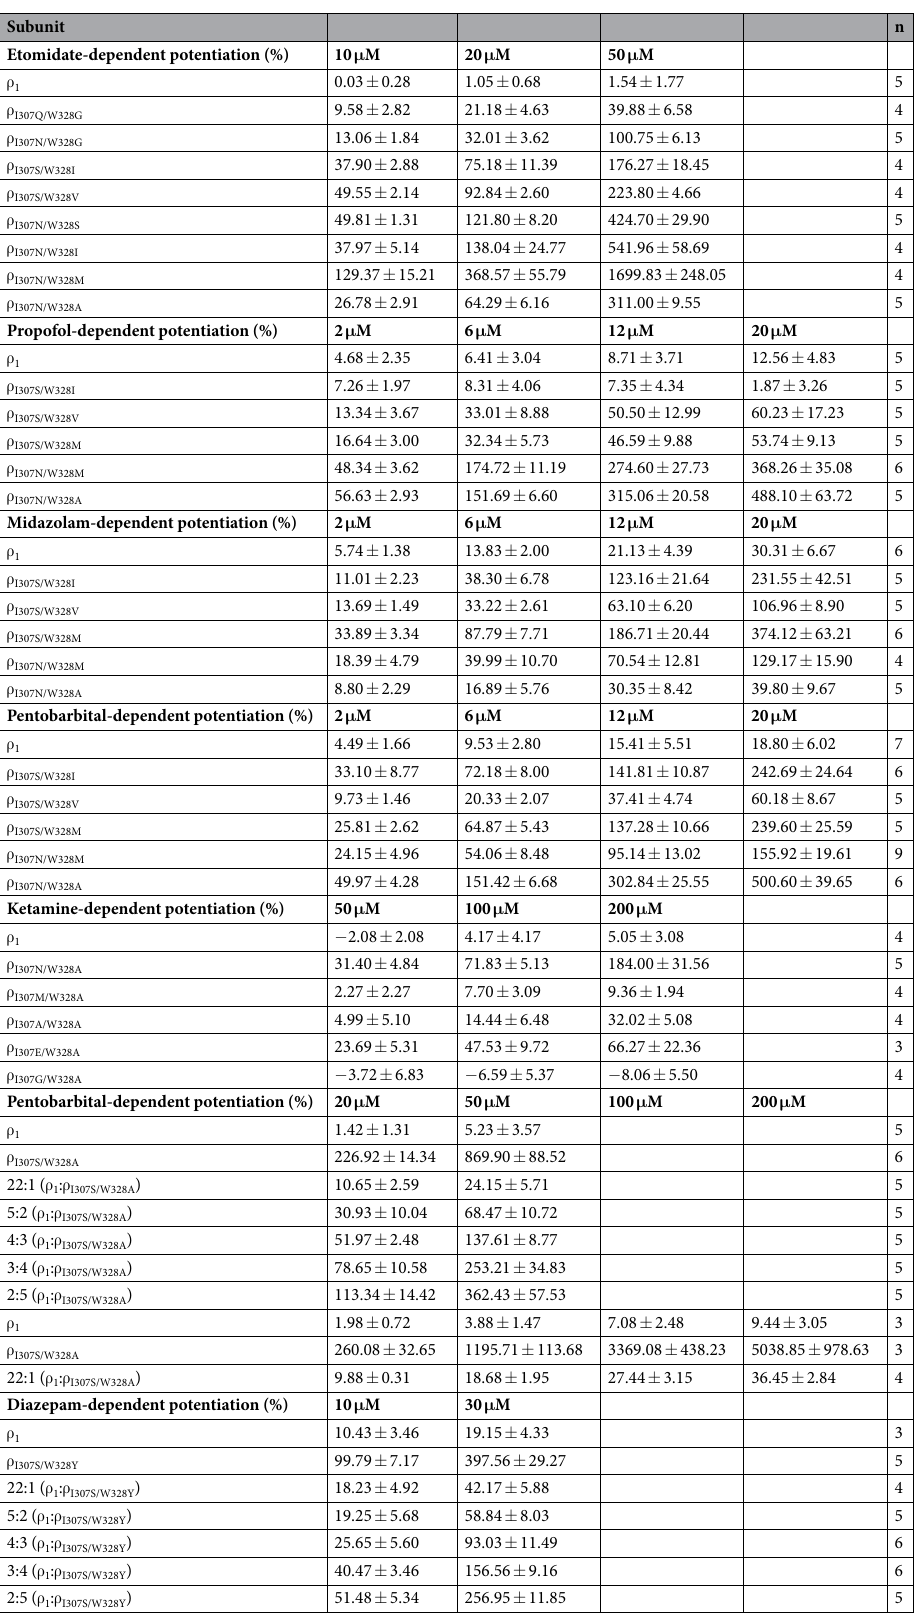
Table 2. Potentiation values (% increase) of etomidate, propofol, midazolam, and pentobarbital in the presence of EC 4 GABA in the ρ 1 and ρ 307/328 mutants. Pentobarbital- and diazepam-dependent potentiation of ~ EC 4 GABA arising from ρ 1 and different ratios of ρ 1 mutant to wild-type. All data are presented as the mean ± standard error